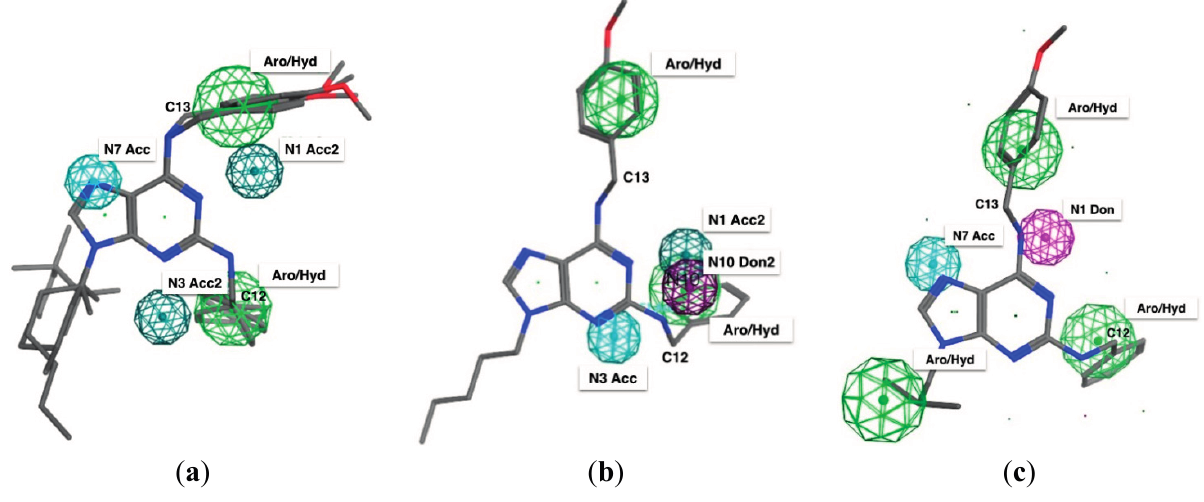
Figure 4. Elucidated pharmacophoric model for 2,6,9-trisubstituted purines against each cancer cell lines: ( a ) Hela; ( b ) H1975 and ( c ) HTC116.